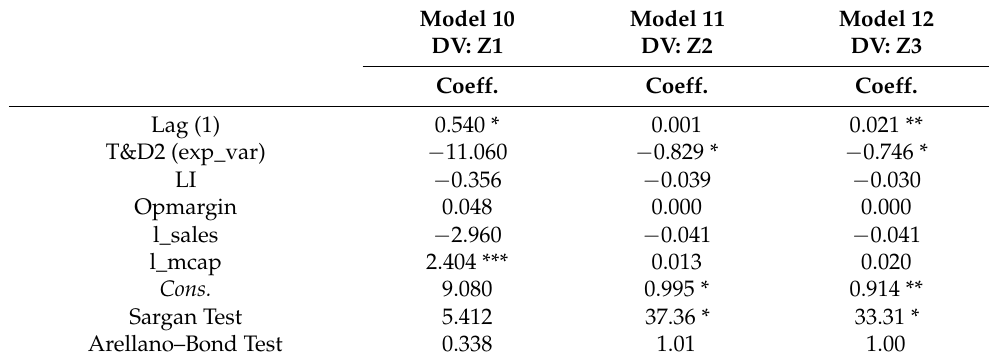
Table 7. Nonlinear Models (Dynamic Panel Data